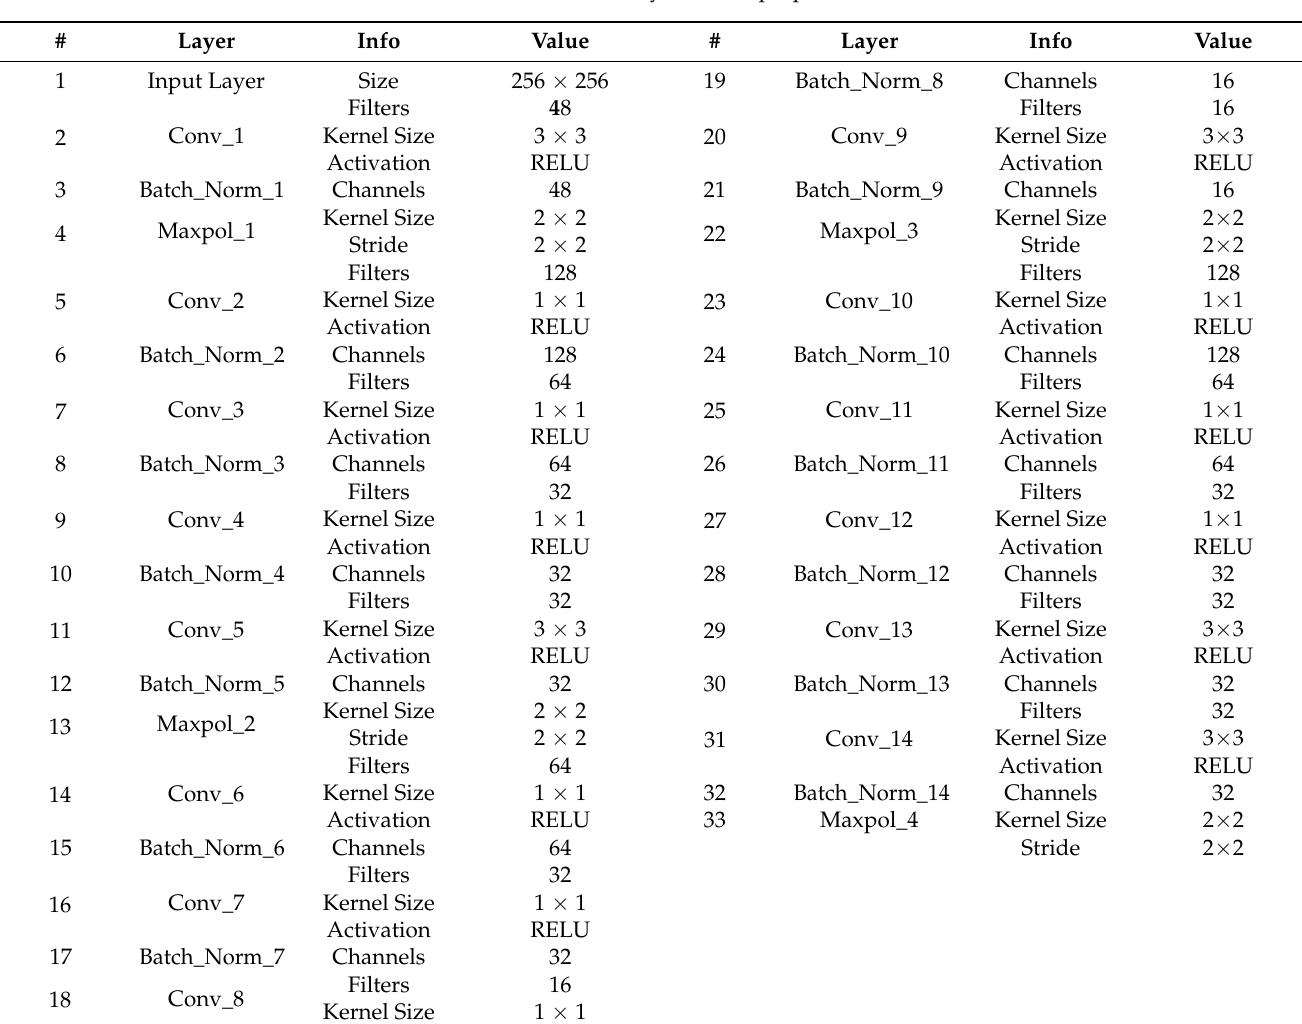
Table 2. Values for information of the layers in the proposed CNN